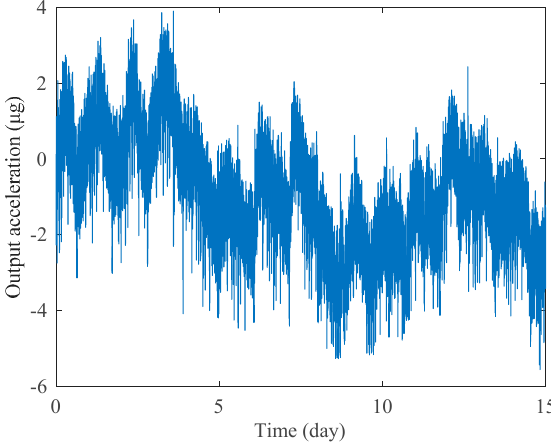
Figure 12. Long-time bias stability measurement of prototype A1 under room temperature.